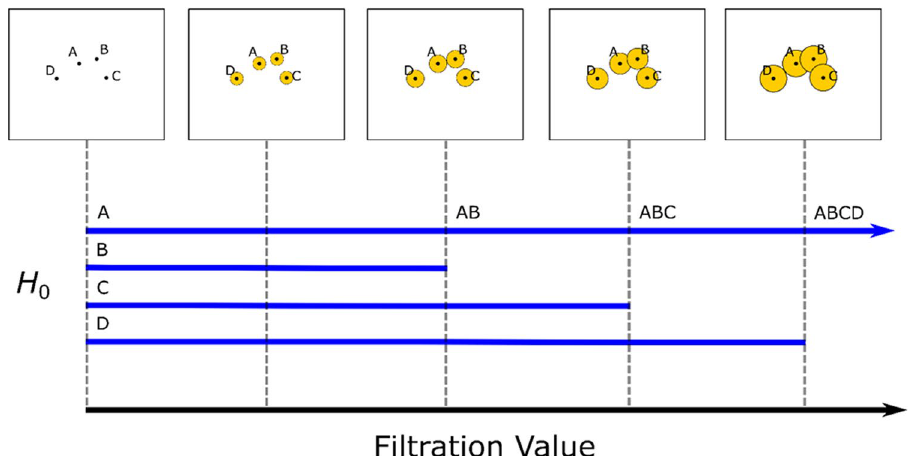
Figure 3. In this schematic representation of persistent homology, the topological space is defined by the four-data points (components) labeled A, B, C, and D in R 2 . The barcodes (solid lines) represent the lifetime of the components, whose length is determined by the filtration value. In this case, the filtration value is the radius of the ‘growing’ disc centered at each component. A connection between components is established at the contact point of two ‘growing’ disc. In the barcode, this event is represented by termination of a barcode for one component and simultaneous representation of the connected component by a single barcode. For example, in the third image, the discs of components A and B come in contact. This event is represented by termination of barcode for B, while simultaneously the barcode for A now represents the connected components AB until component C is connected. The arrow head indicates that the filtration value can increase to